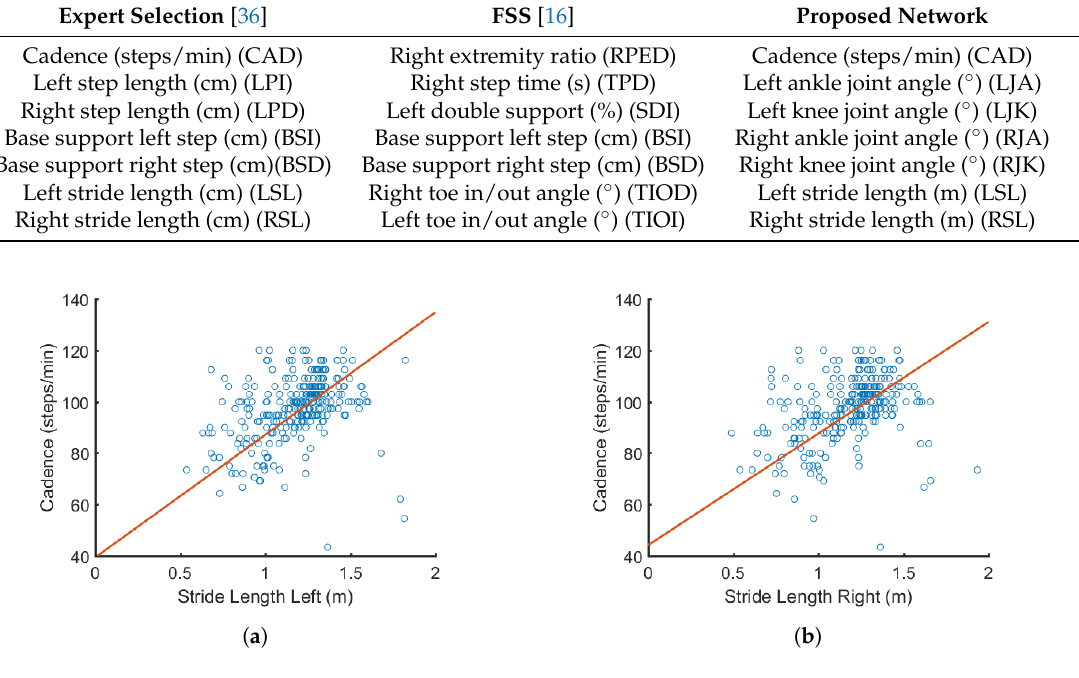
Figure 5. Example of how cadence is correlated with: ( a ) left stride length ( R = 0.6941); and ( b ) right stride length ( R = 0.6529). Correlations are later used to form the connections in the